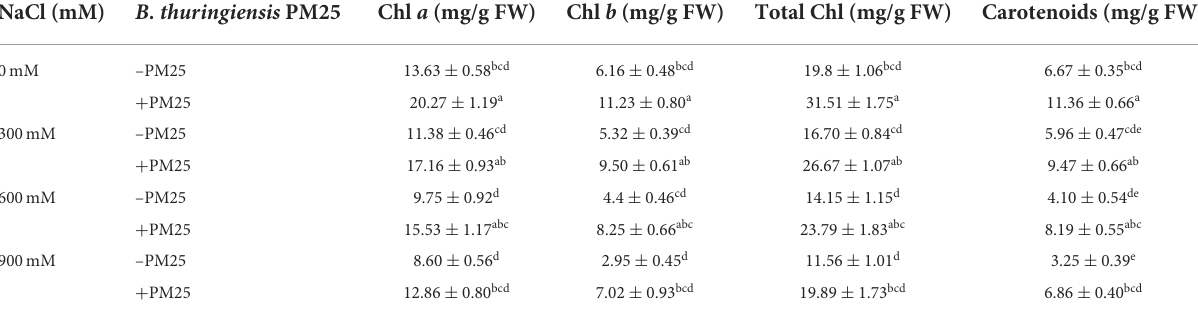
TABLE 4 Pigmented content of maize in the presence and absence of Bacillus thuringiensis PM25 under salinity stress. NaCl (mM)